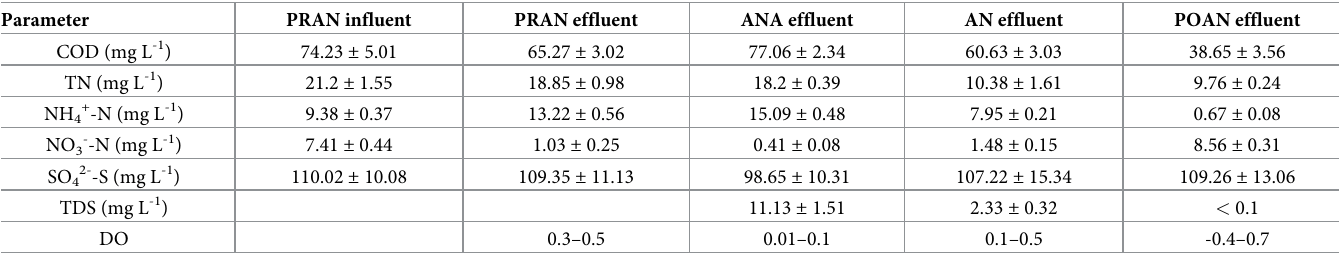
Table 1. Performance of the PRAN, ANA, AN and POAN chambers. Parameter PRAN influent PRAN effluent COD (mg L -1